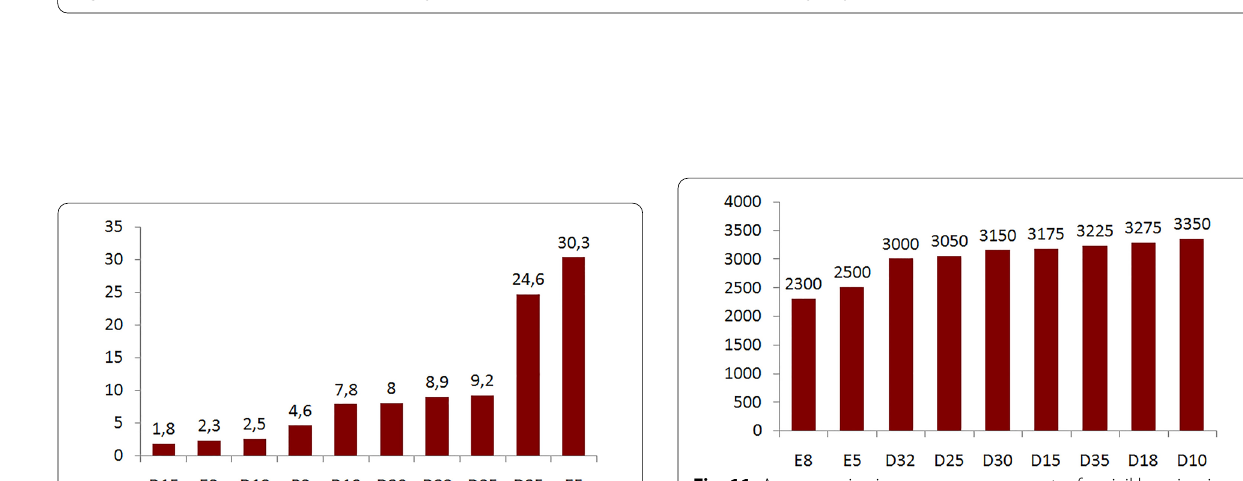
Fig. 9 OMI zones of reference of the sending areas. Author’s elaboration on data Revenue Agency 2020